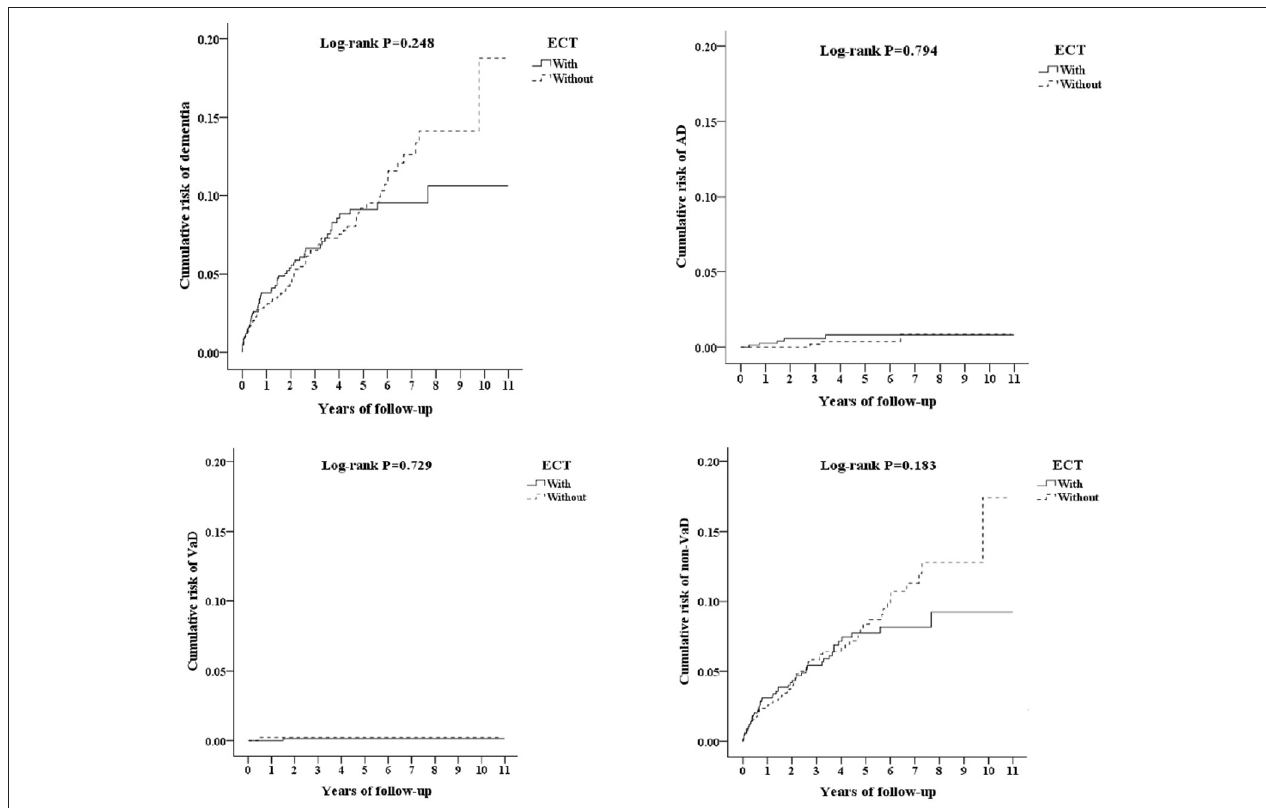
FIGURE 2 | Kaplan-Meier for cumulative risk of dementia among schizophrenia/bipolar disorder/major depressive disorder aged 20 and over stratified by ECT with log-rank test (Left-top, All dementia; Right-top, AD; Left-bottom, VaD; Right-bottom, other dementia).